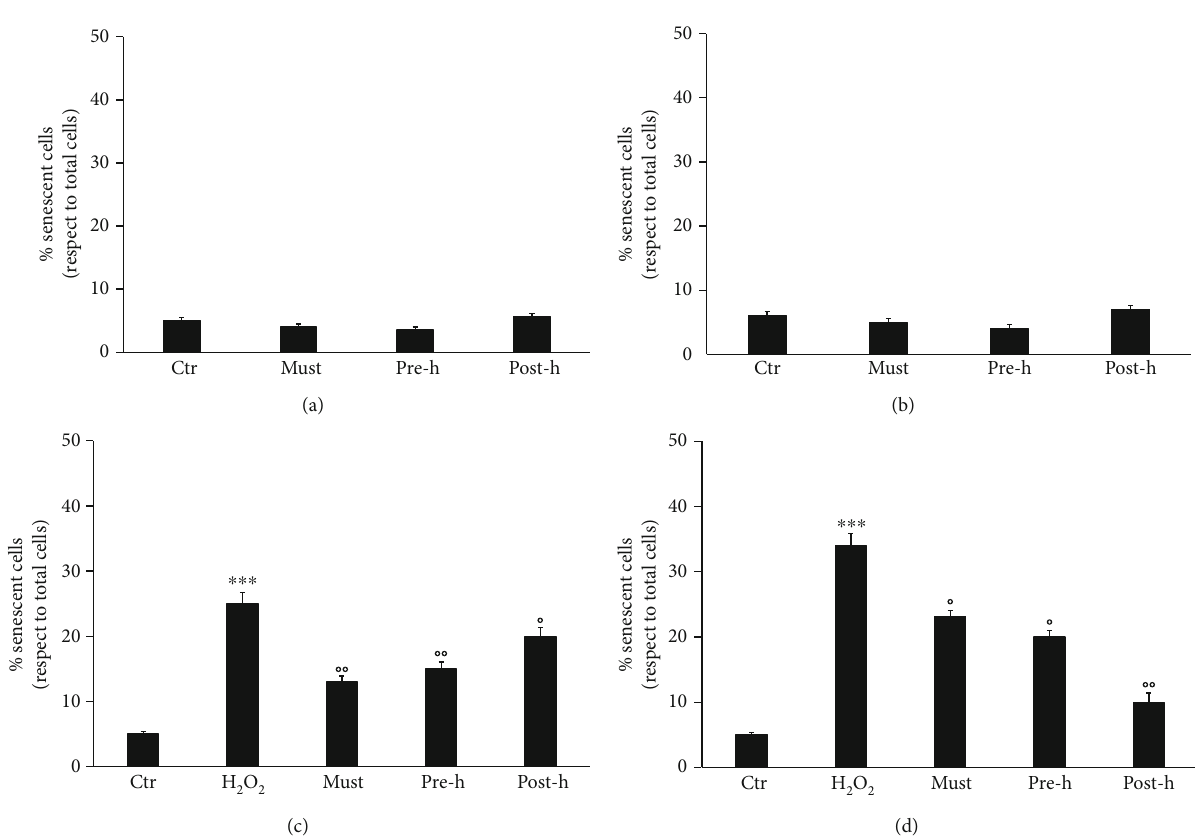
Figure 4: Antisenescent e ff ect of beer fractions on D-dSCs and Caco-2 cells. Senescence-associated beta-galactosidase (SA- β -Gal) was detected. (a) D-dSCs; (b) Caco-2, percentage of cellular senescence in not-injured cells treated with beer fractions solution: must (must), prehopping solution (pre-h), and posthopping solution (post-h). (c) D-dSCs; (d) Caco-2, percentage of cellular senescence in H injured cells treated with beer fractions solution: must (must), prehopping solution (pre-h), and posthopping solution (post-h). Data is shown as the percentages of β -galactosidase-positive cells with respect to the total cell number of the sample. Each bar represents the mean ± SEM of three replicates from three independent experiments. ∗∗∗ p < 0 : 001 versus the control (Ctr, cells not injured); ° ° p < 0 : 01 versus the H O ; ° p < 0 : 05 versus the H O . 2 2 2 2